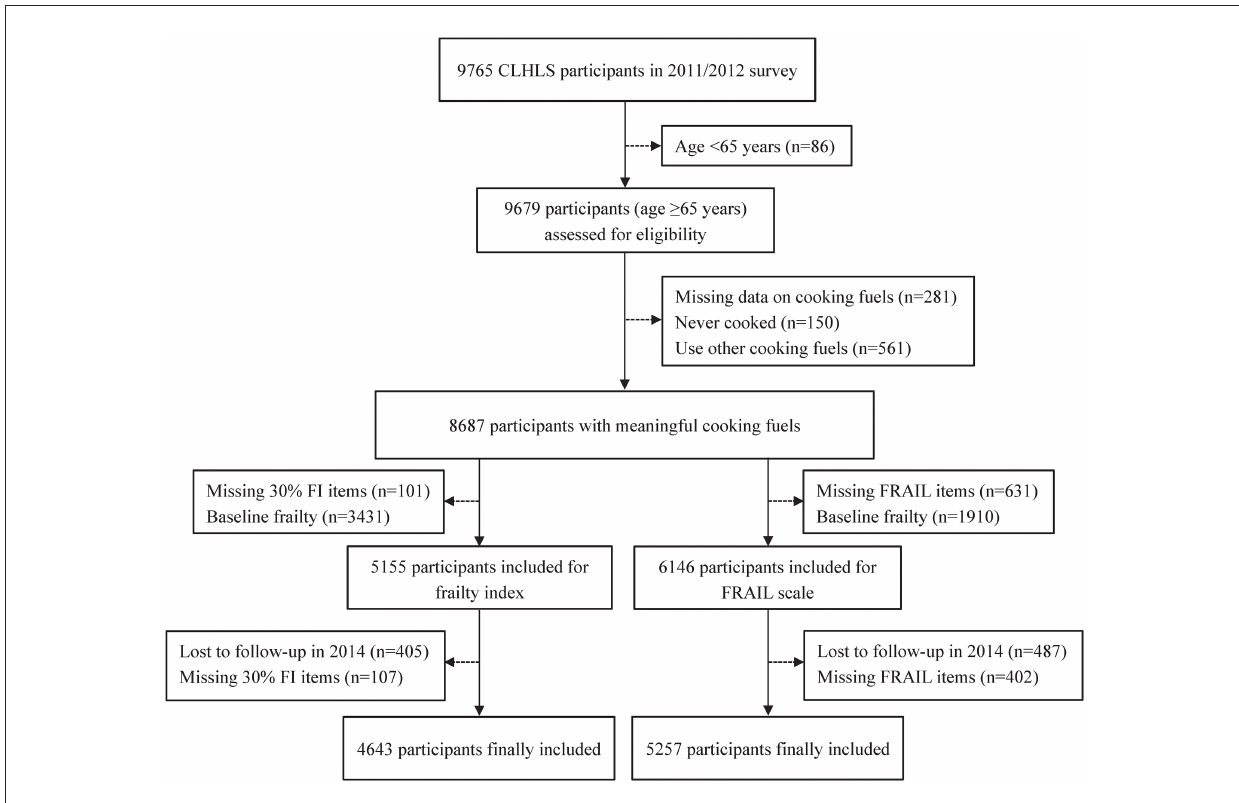
FIGURE1 Flow chart of participants’ selection. FI, frailty